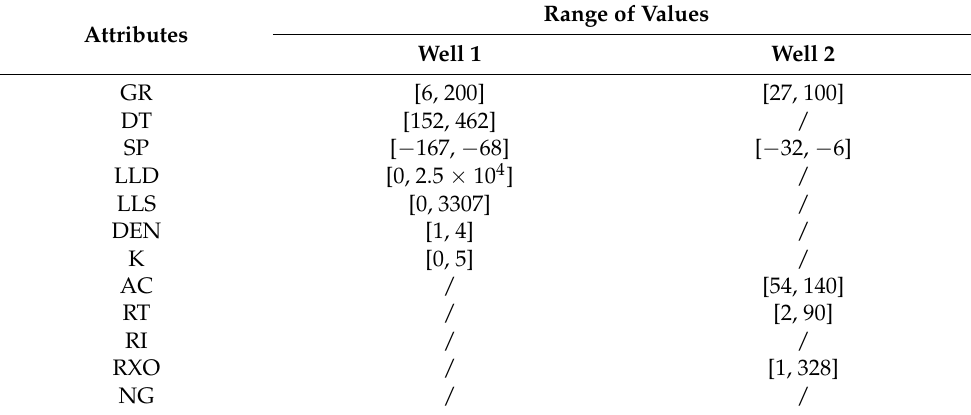
Table 6. Range of values for each attribute after attribute